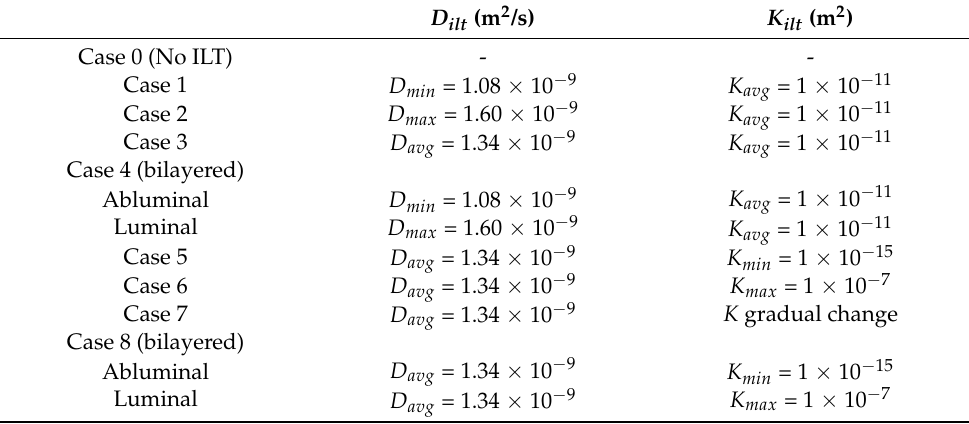
Table 2. Parameter sets for simulated cases. The different values for oxygen diffusivity and perme- ability are listed for Case 0 to 8. Case 0 represents the case without the ILT, hence there are no values for oxygen diffusivity and permeability. Cases 1, 2, 3, 5, 6, and 7 contain one-layered ILT models, and Cases 4 and 8 contain two-layered ILT models with distinct luminal and abluminal